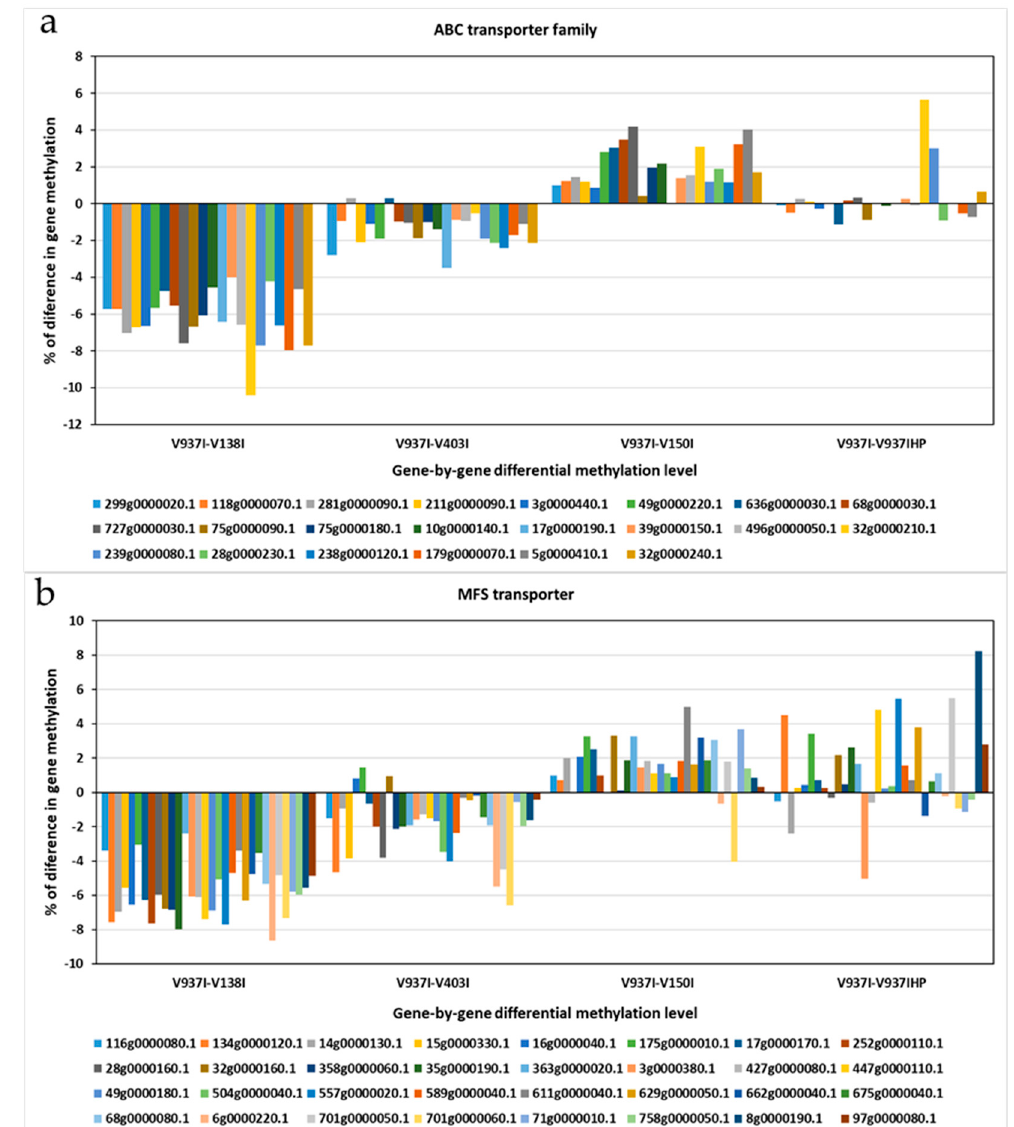
Figure 5. The differential methylation profile of the annotated genes for the two major transporter superfamilies. The gene methylation pattern of the Verticillium dahliae D isolates compared to reference isolate V937I is represented for each gene. ( a ) ATP-Binding Cassette (ABC) transporter superfamily. ( b ) Major Facilitator Superfamily (MFS) transporters superfamily. The methylation differences between isolates for each gene was calculated from average data in the biological replicates. Gen ID can be consulted in Table S2.